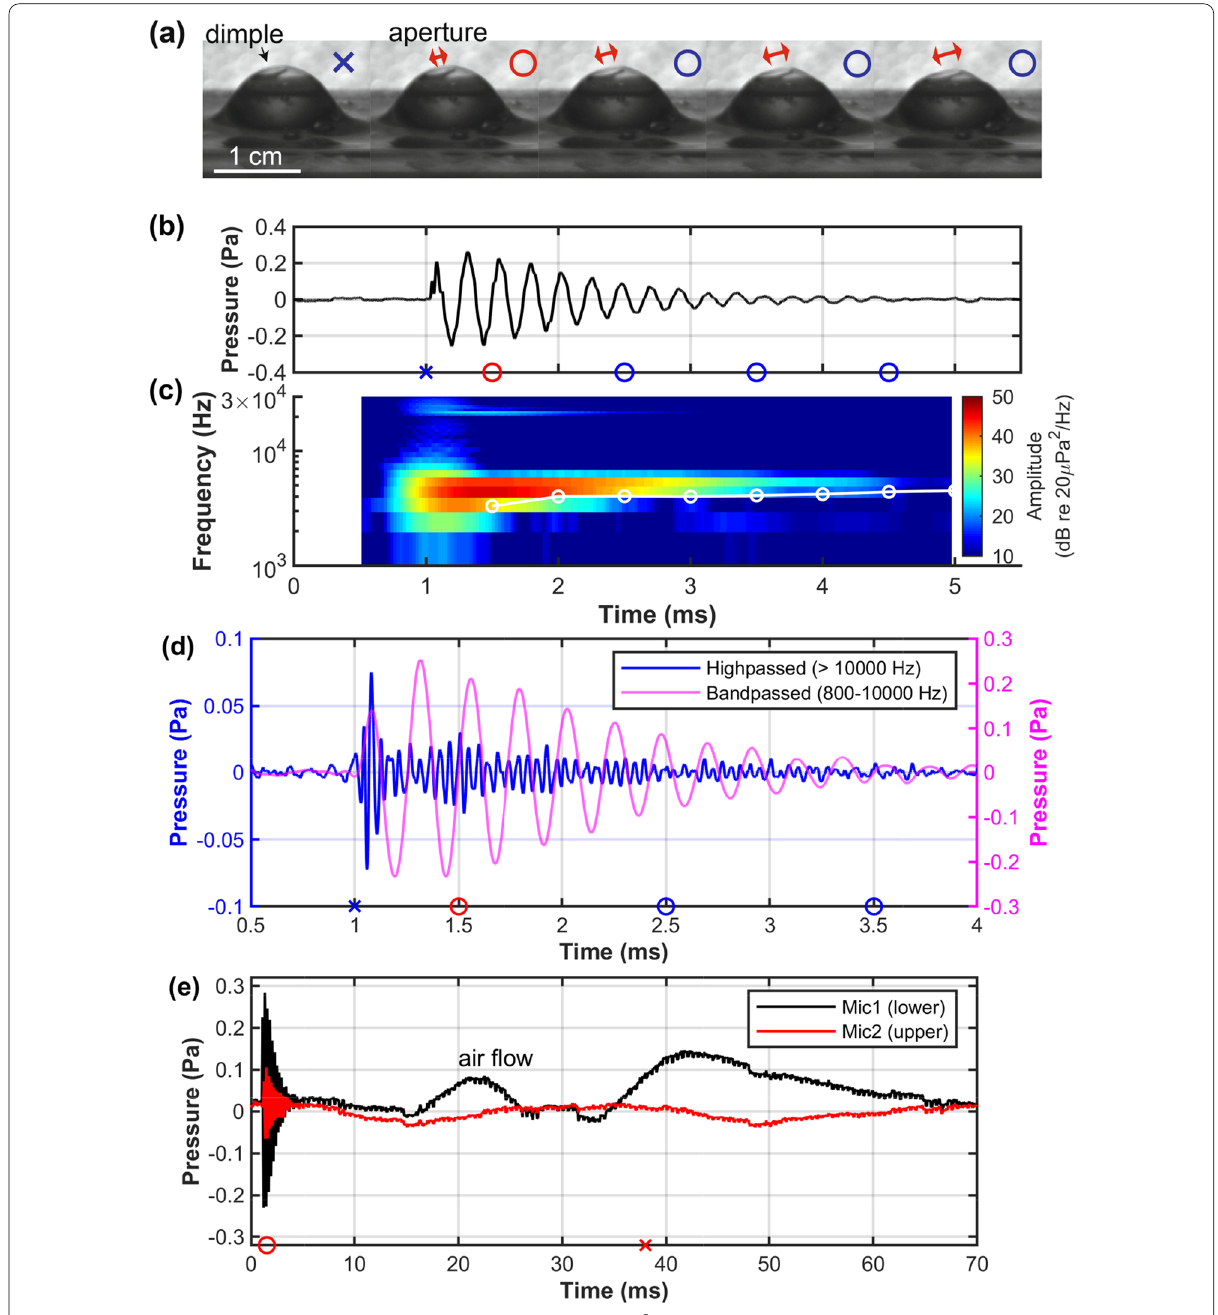
Fig. 6 An example of Helmholtz resonance (small bubble, case 5). V = 0.6 cm 3 bubble bursts while it is rising in a suspension of φ = 0.4 . a Time-lapse images (see Additional file 2: Movie 2). × and (cid:31) indicate before and after aperture opening, respectively. b Waveform (detrended, highpass filtered at > 800 Hz). c Spectrogram of ( b ) using a 1.024 ms sliding window and a 1 ms overlap. (cid:31) indicates f H calculated from Eq. (11) using measured R a . d High- ( > 10000 Hz, left axis) and bandpass (800 - 10000 Hz, right axis) filtered result of ( b ) shown for a shorter time span. e Waveform shown for a longer time span (running-averaged raw data) indicating Helmholtz resonance followed by a low-frequency air flow. A red × indicates the time of film